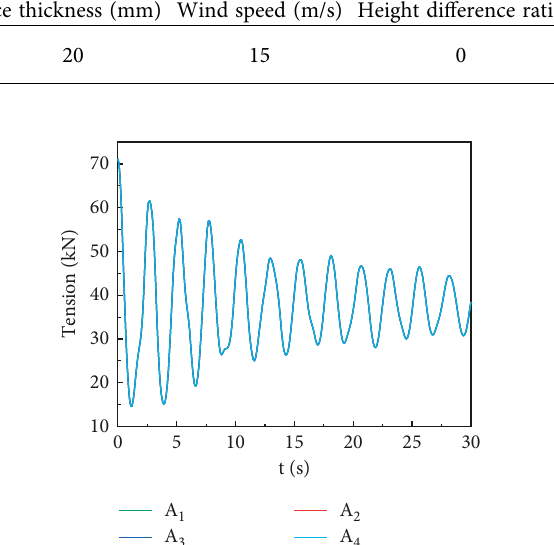
Figure 6: Tension-time curve of conductor hanging point (syn- chronous ice